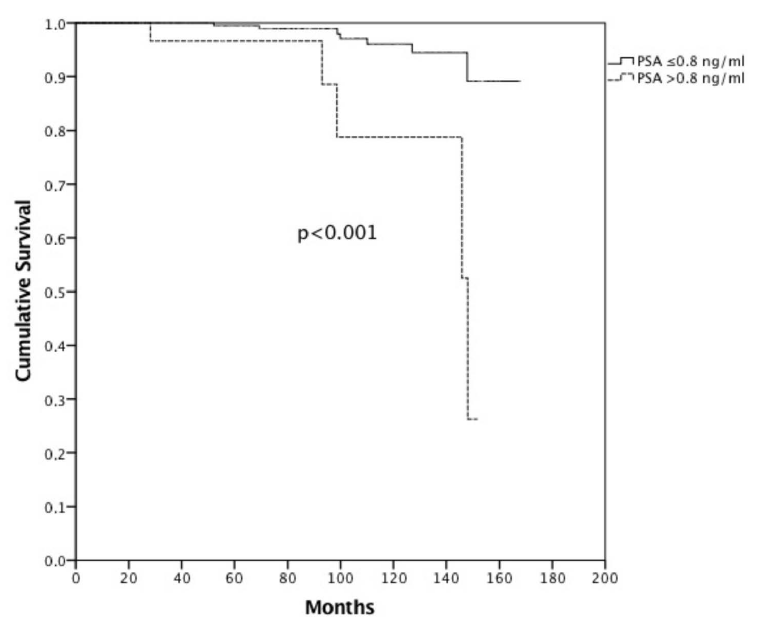
Figure 2. Cancer-specific survival in patients with PSA ≤ 0.8 ng/mL at first follow-up vs. >0.8 ng/mL.